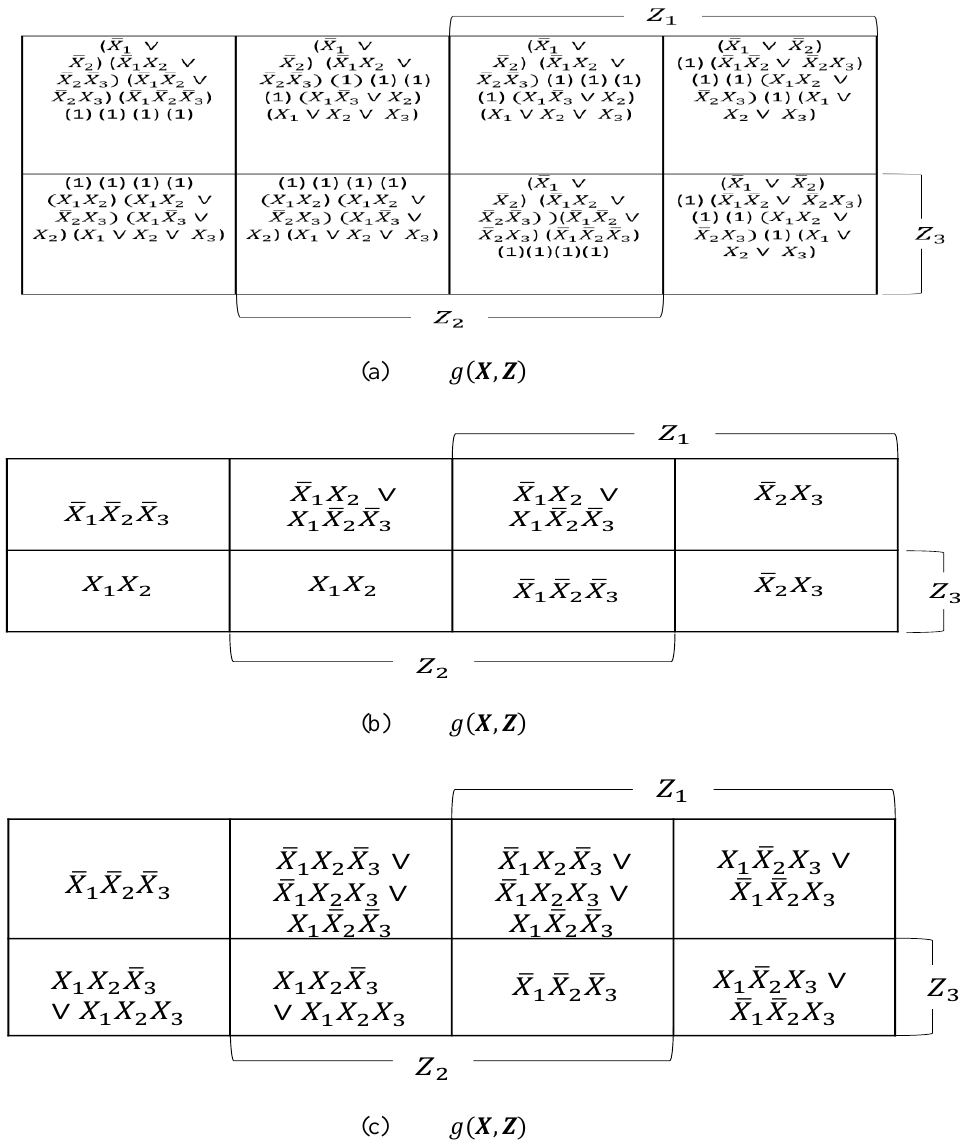
Fig. 3. The function 𝑔(𝑿, 𝒁) in Example